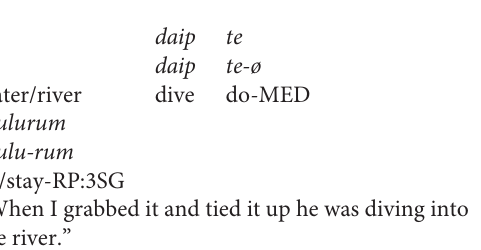
FIGURE 5 | Mean number of events referred to in the children’s two-clause